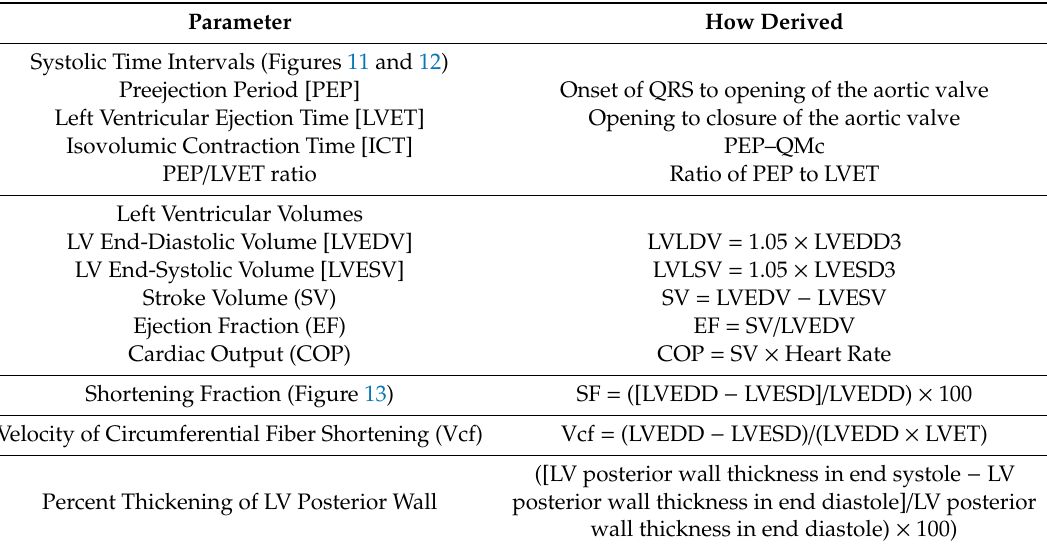
Figure 13. Selected M-mode recording from the parasternal short axis view of the left ventricle at the tips of the mitral valve illustrating measurements of left ventricular end-diastolic (LVEDD) and end-systolic (LVESD) dimensions to calculate shortening fraction (see Table 1). Reproduced from Rao P.S., Kulangara R.J. [5]. Table 1. Left Ventricular Function Parameters Examined.